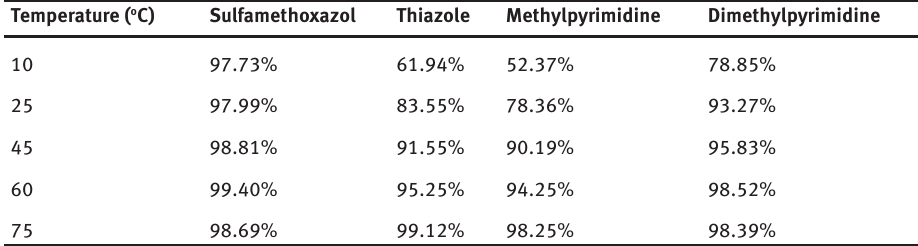
Table 3: The removal efficiency of different pollutants over biochar under different temperatures. Temperature ( o C)